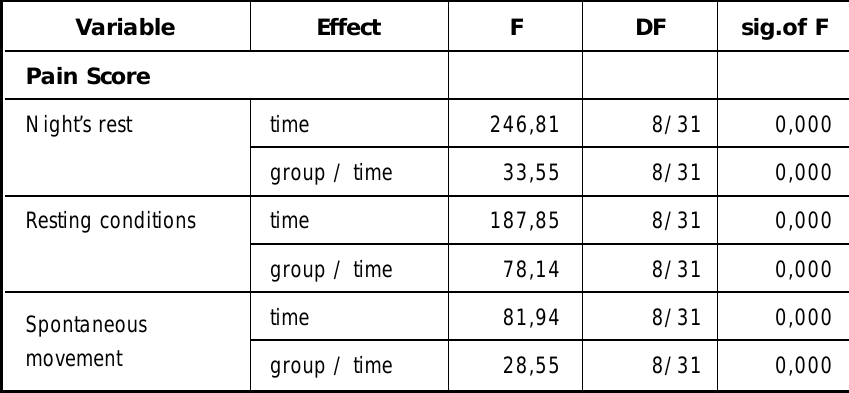
Table 2: Results of the Multivariate Tests (Wilks Roys) for Pain Parameters.